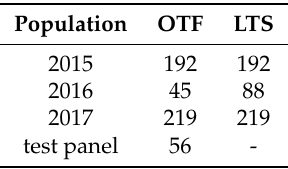
Table 2. Number of lines with sufficient genotype and phenotype data for further analysis. The three populations (2015–2017) from the third field evaluation year were used for GWAS and development of genomic prediction models. A collection of lines from highly unbalanced multi-location and multi-year trials (test panel) was used to further evaluate the prediction models developed with the 2015–2017